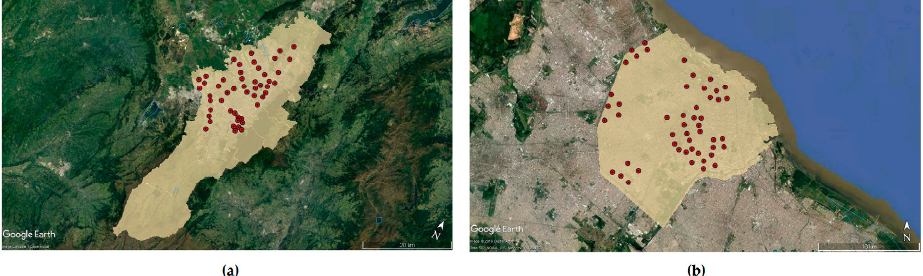
Table 1. Selected Latin American megacities and respective relevant